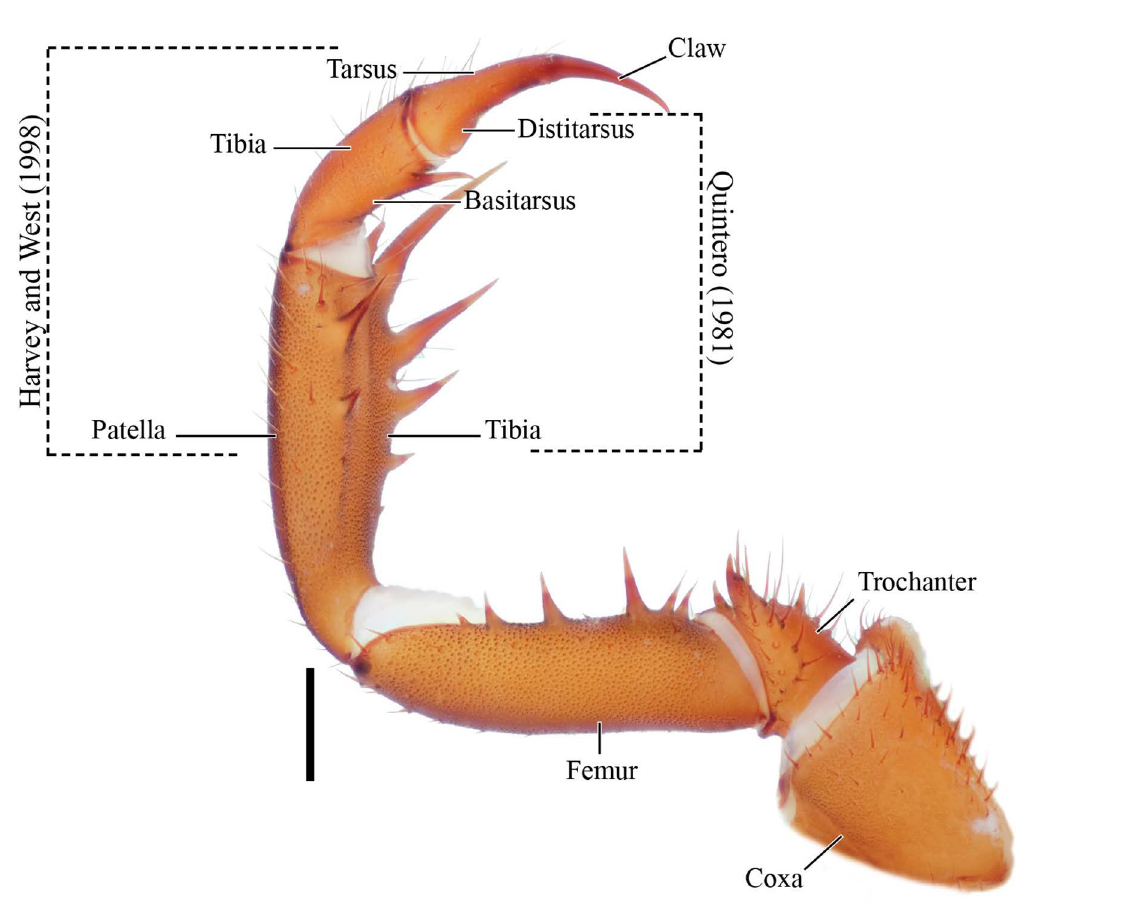
Fig. 2. Charinus insularis Banks, 1902 (RBINS), dextral pedipalp, ventral view, illustrating nomenclature for pedipalp segments. Scale bar: 1